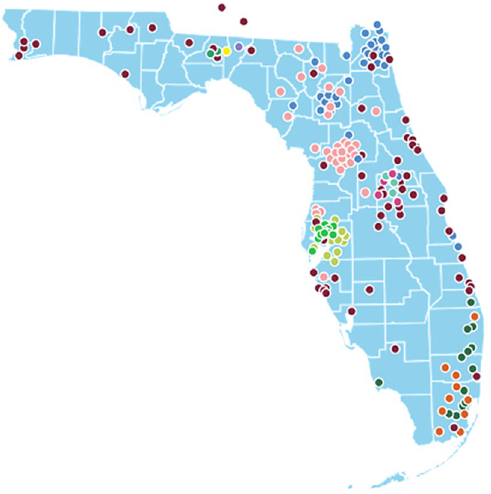
Figure 4. Map detailing locations of OneFlorida clinical partners.